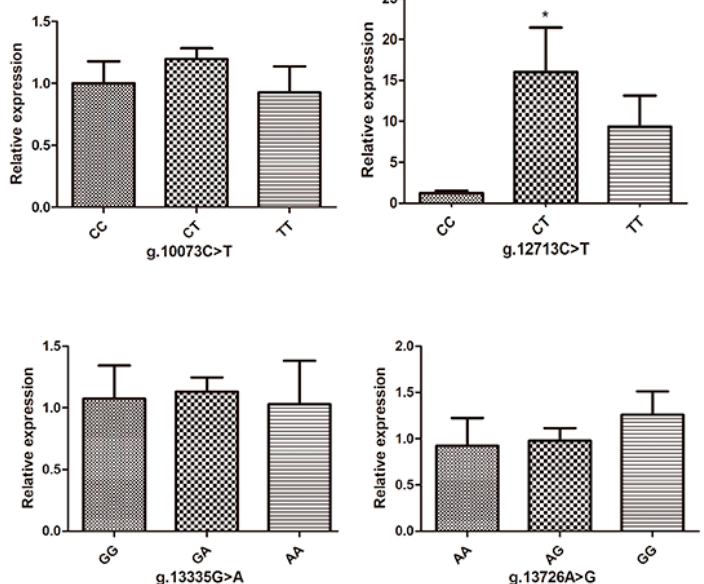
Figure 4. Relative expression levels of the chicken PITX2 mRNA in leg muscle with different genotypes in the loci of g.10073C > T, g.12713C > T, g.13335G > A and g.13726A > G with the average Δ Ct value of CC, CC, GG and AA genotype as the calibrator, respectively. Data were shown as the mean ± SEM for 10 chickens of each genotype. The column with “*” showed a significant difference ( p < 0.05).